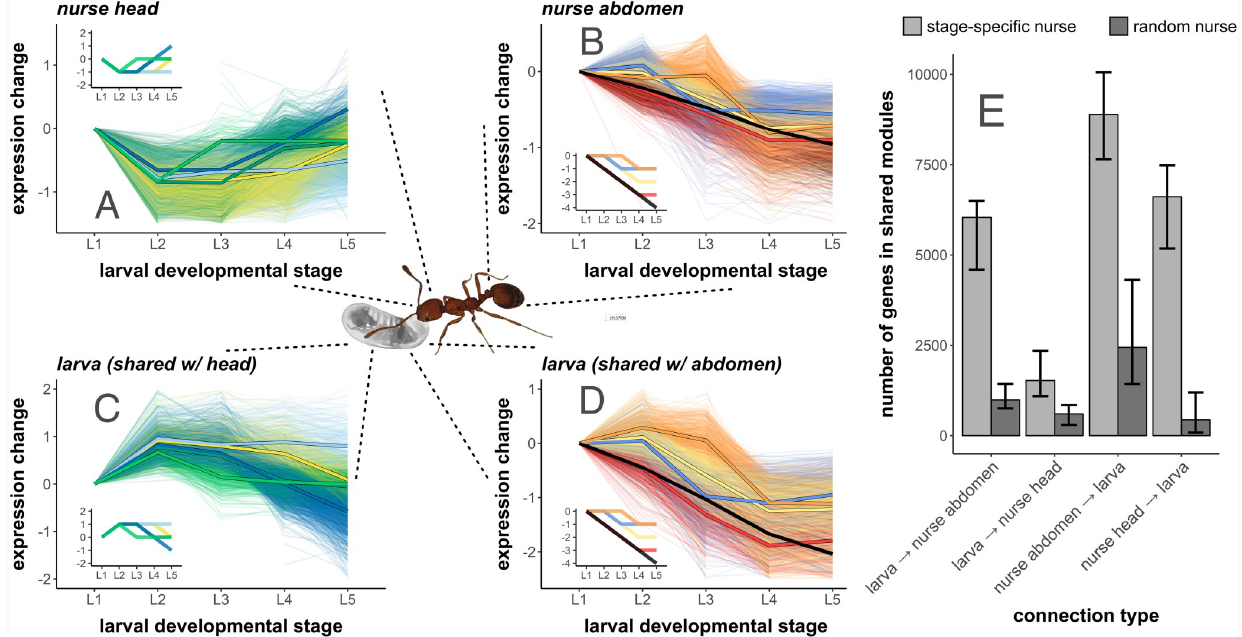
Fig 2. Nurse and larval transcriptomes show strong signatures of gene co-expression across larval development. Plots (A-D) depict the expression profiles of individual genes (light lines) as expressed in (A) nurse head, and (B) nurse abdomens, as well as (C) larvae, shared with nurse heads, and (D) larvae, shared with nurse abdomens. Dark lines indicate the median expression values of all genes sorted into modules, with pre-defined expression profiles of modules depicted in plot insets. Colors indicate the pre-defined expression profile (i.e. module) that genes have been sorted into. Only the five shared modules containing the most nurse-expressed genes are shown for clarity. Larval expression profiles are divided by the nurse tissue they are shared with, such that (C) depicts larval gene expression shared with nurse heads (A), while (D) depicts larval gene expression shared with nurse abdomens (B). Note that nurse heads and larvae shared inversely-related expression profiles, and that this algorithm does not reveal the direction of regulation as it is simply correlation-based. (E) Stage-specific nurses have more genes than random nurses in modules shared with larvae than do random nurses, reflecting more broad-scale co-expression across development. “Connection type” refers to the tissue that the number of genes was calculated in (i.e. larva ! nurse head indicates the number of genes expressed in larvae that are in modules shared with nurse heads), though directionality is not determined in this algorithm. Error bars indicate 95% confidence intervals derived from systematic drop-1 jackknifing of nurse samples. N = 10944 genes total.